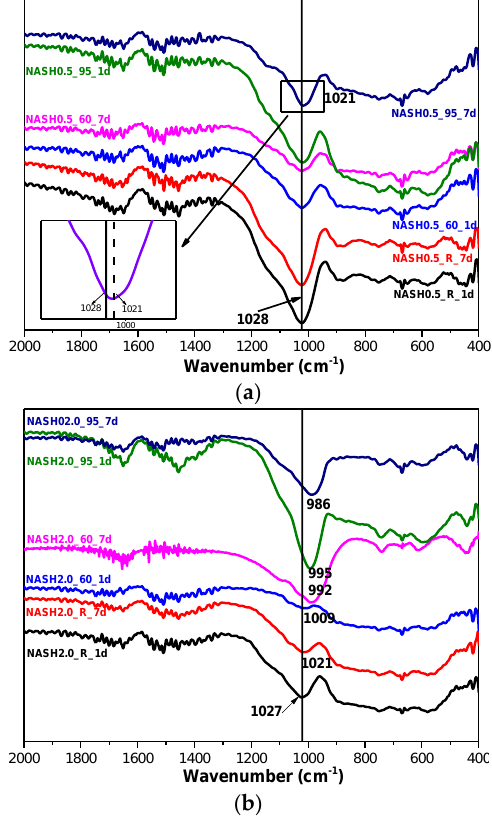
Figure 8. FTIR spectra of N-A-S-H system products. ( a ) Na 2 O/SiO 2 is 0.5; ( b ) Na 2 O/SiO 2 is 2.0.